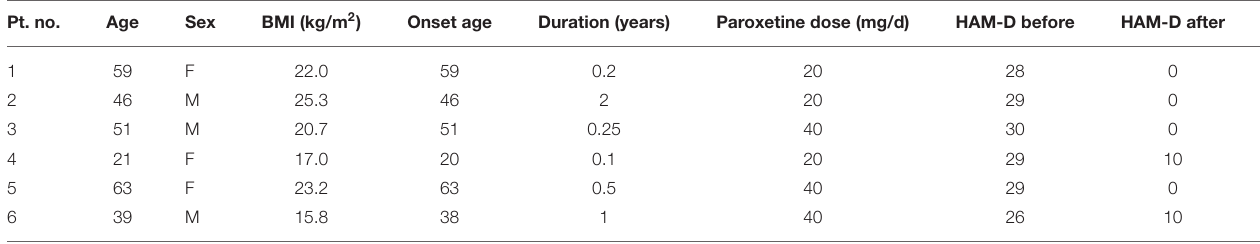
TABLE 1 | Demographic data of paroxetine responsive patients with MDD. Pt. no.